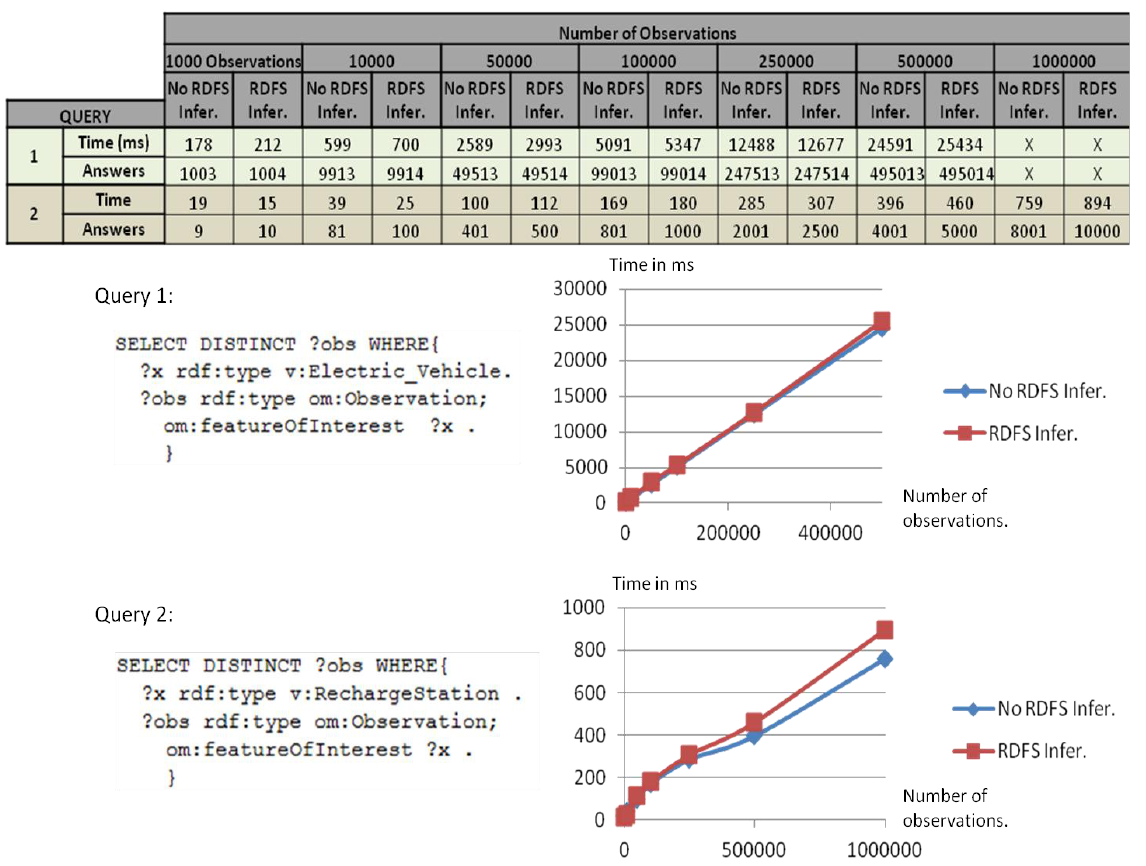
Figure 9. Response times for queries returning different amounts of results from the SPARQL